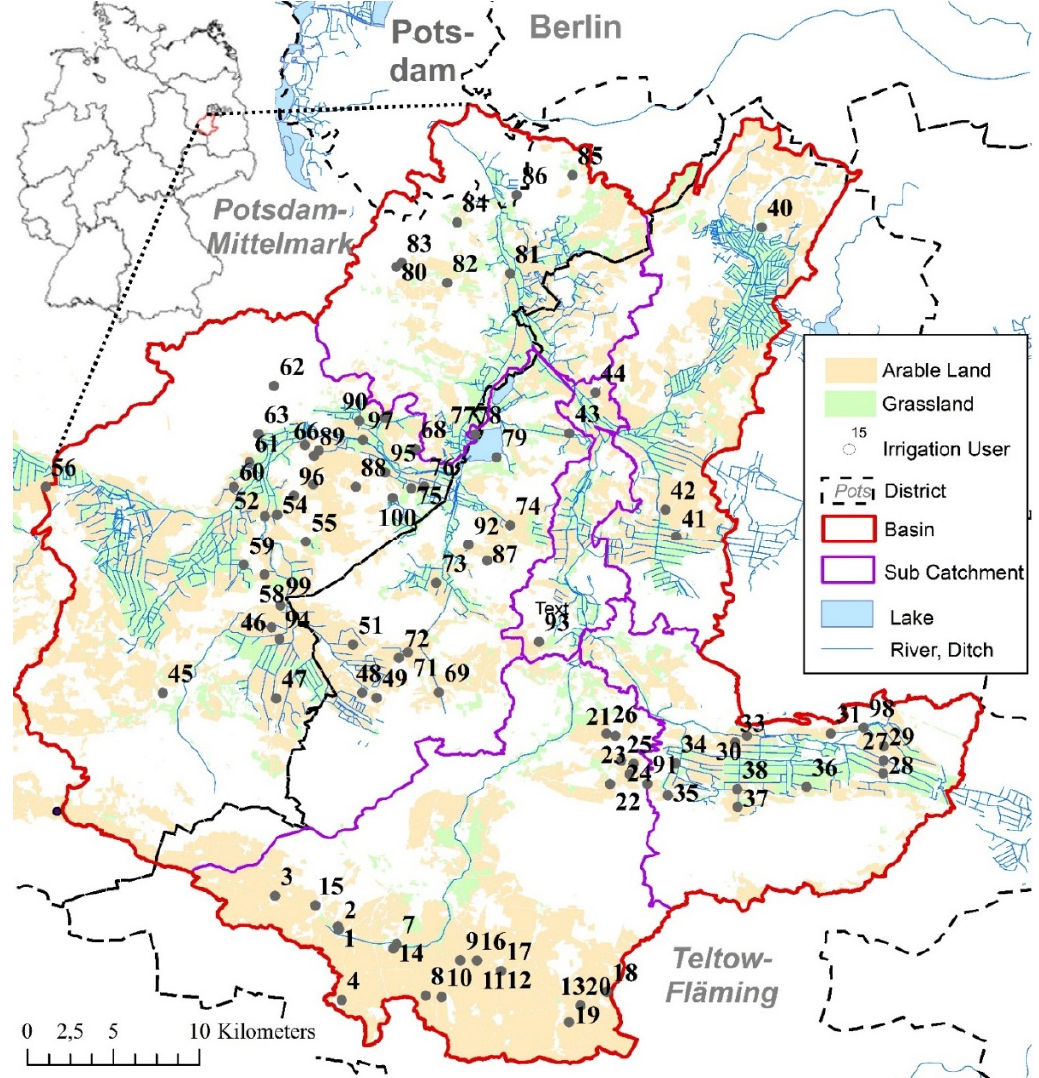
Figure 4. Agricultural land use of the study site and location of agricultural irrigation users as well as sub-catchments in the simulation